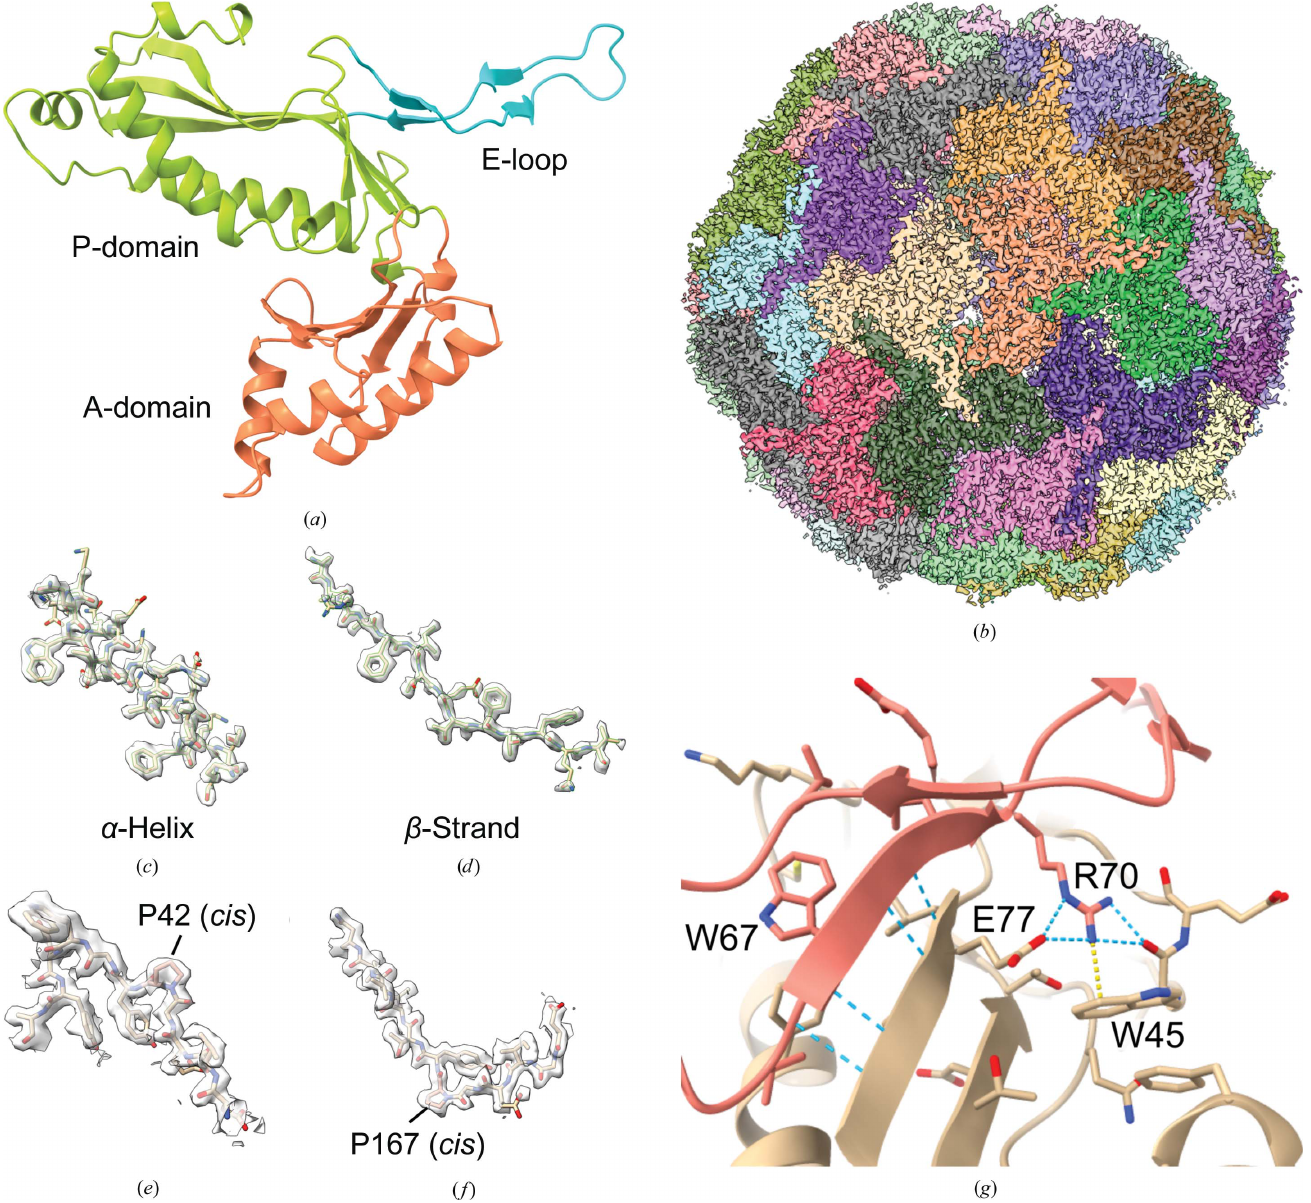
Figure 1 Density maps and model of TmEnc. ( a ) Domain organization of an encapsulin monomer, as viewed from the inside of the compartment. ( b ) Cryo-EM density map for the entire encapsulin nanocompartment. Subunits are colored individually. ( c ) Representative cryo-EM density for an (cid:2) -helix (residues 14–30). ( d ) Representative density for a (cid:3) -strand (residues 241–254). ( e , f ) Density for two cis -prolines, which were previously not observed. ( g ) Intermolecular interactions between the E-loop domain (tan) and another subunit (pink). Blue dashed lines indicate hydrogen bonding, and the yellow dashed line is a cation– (cid:4)